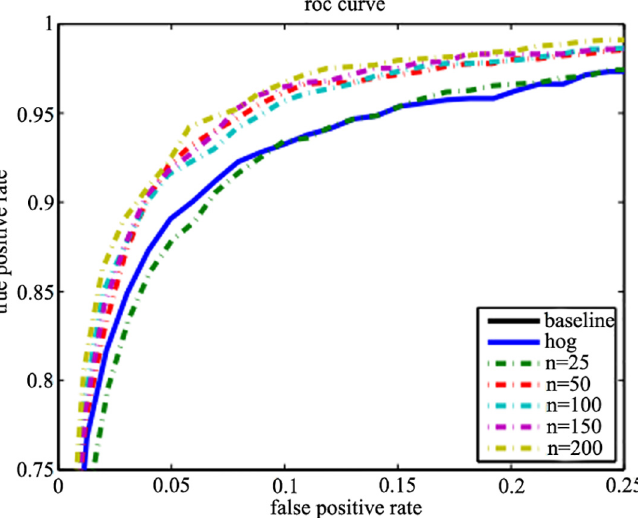
Fig 4. The performance of integral histogram with different number of block pairs n